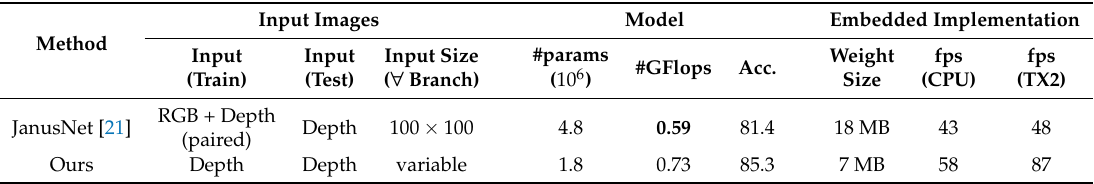
Table 2. Comparison between the proposed model and JanusNet [21]. Requirements in terms of input images, model parameters (number of weights, computational load, and final accuracy on the face verification task obtained on the Pandora dataset), and details on the embedded implementation are provided. Pros are highlighted in bold.